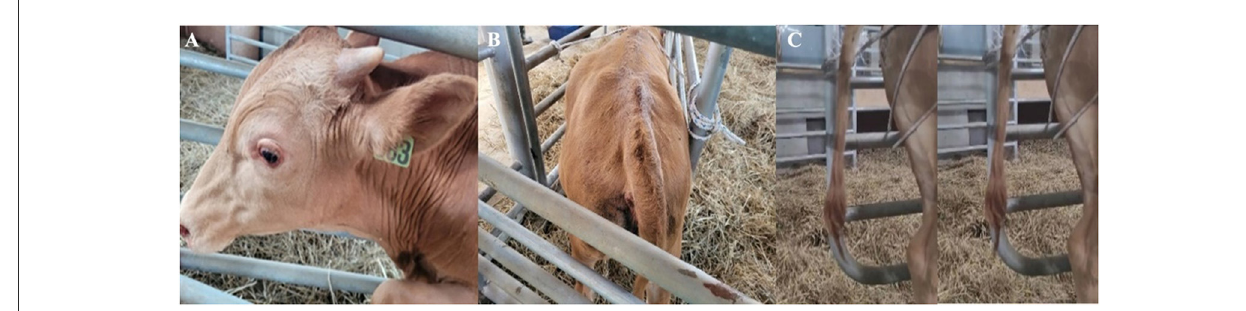
FIGURE1 The early onset clinical symptoms of the patient with tetanus. The increase in neck muscle stiffness rendered it unable to be flexed manually. In addition, the ears were pulled back, and protrusion of the third eyelid was observed (A) . The coccyx is elevated and the left shoulder is bloated (B) . Cramps and twitching of the tail were also observed (C) .